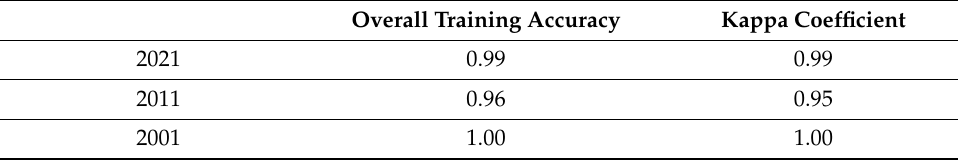
Table 6. Overall accuracy and kappa coefficient of the classification.